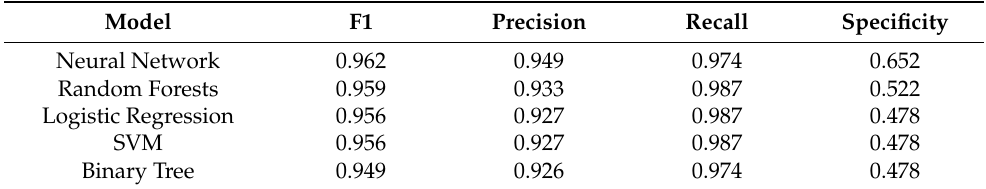
Table 10. Models accuracy metrics for not adding a product from recommending interface (class 0) with add_to_cart_both as target